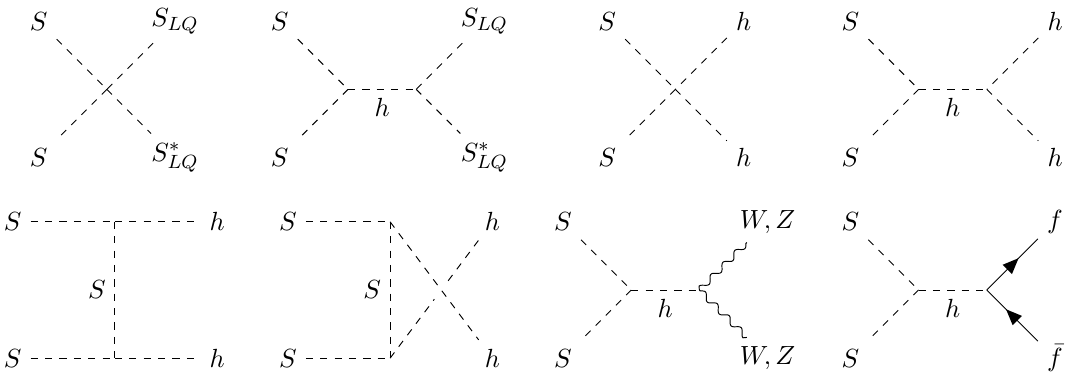
Figure 3 . Feynman diagrams for annihilations of scalar dark matter at tree